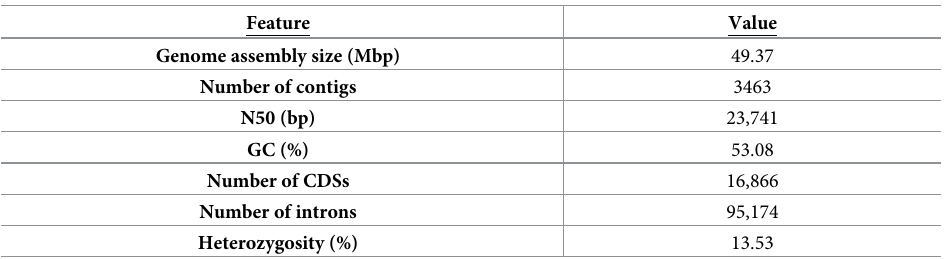
Table 1. Assembly of the D . pusillus LMB4 genome